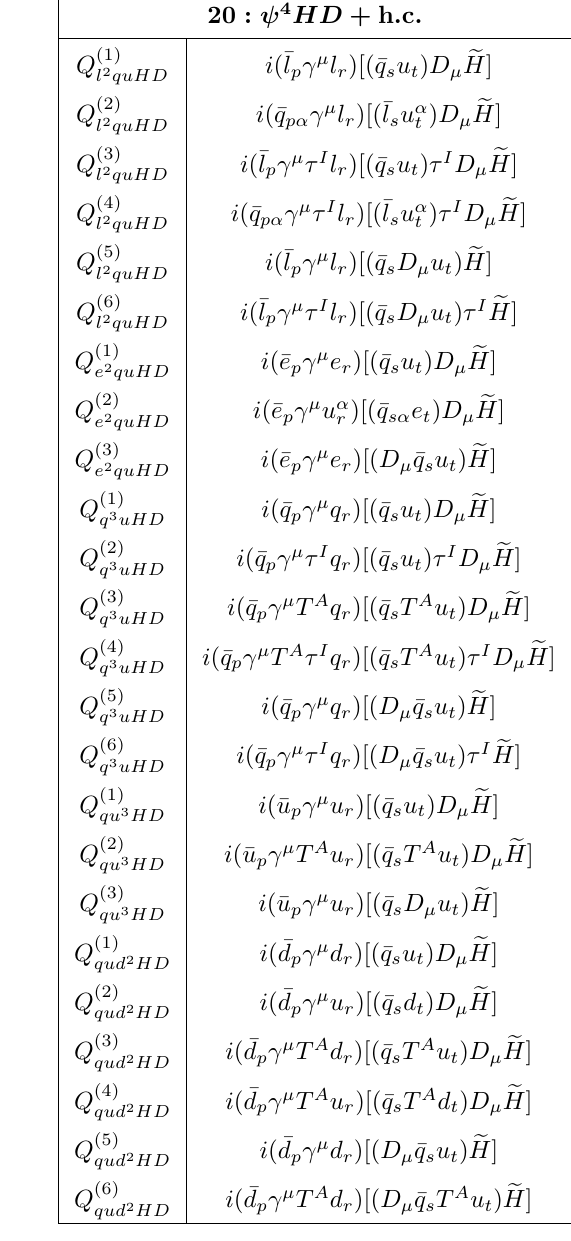
Table 16 . The dimension-eight operators in the SMEFT of class-20 whose (cid:12)eld content super(cid:12)cially includes either an electron-type or up-quark-type Yukawa interaction. All of the operators have Hermitian conjugates. The subscripts p; r; s; t are weak-eigenstate indices. The operator below the dashed line is redundant when there is only one generation of fermions.